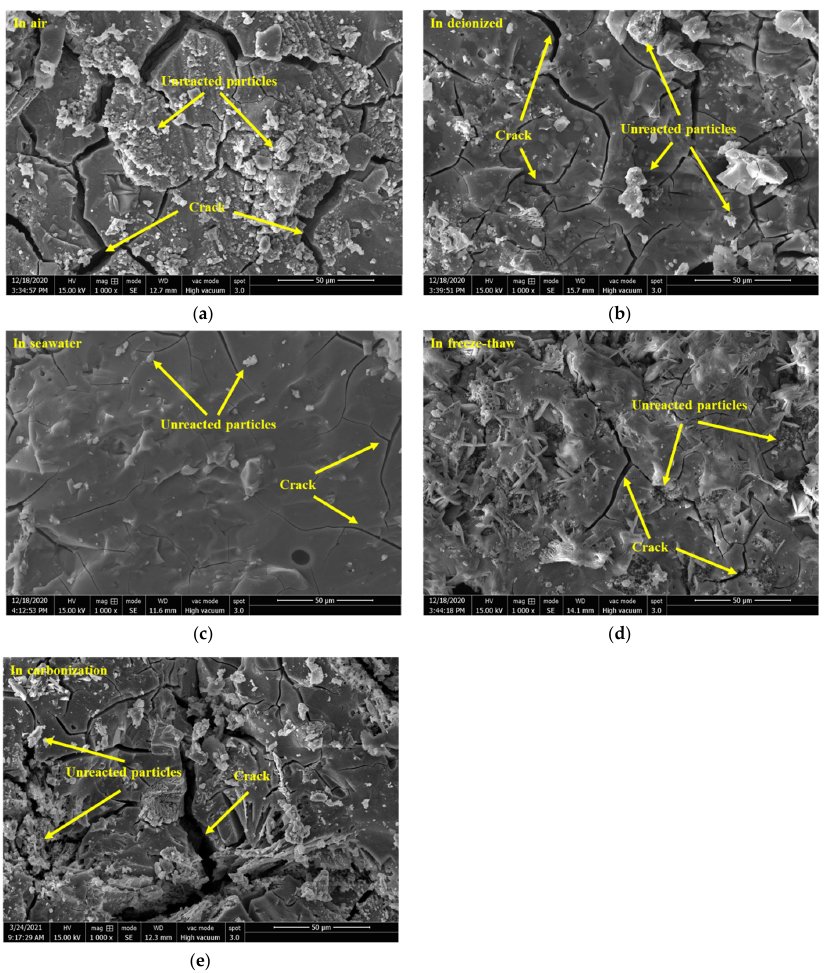
Figure 7. SEM images of the geopolymers prepared with 60% BFS subjected to different exposure.